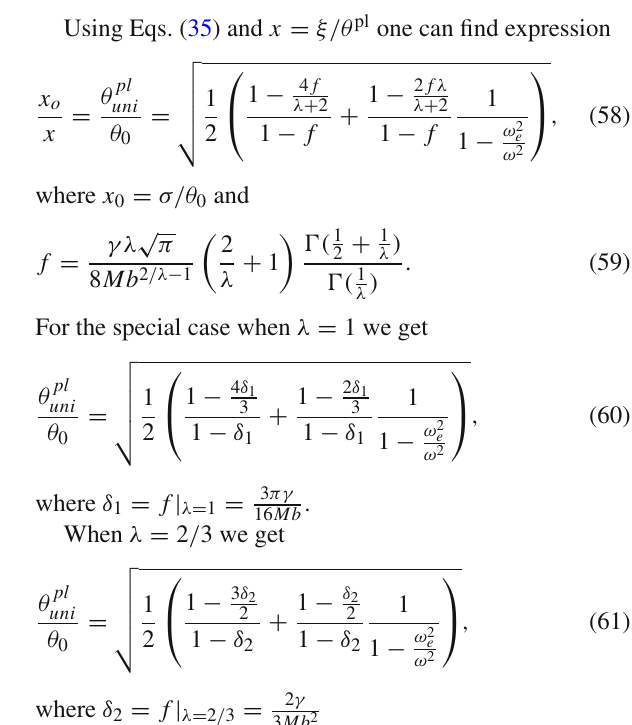
Fig. 18 α b for different value b , d and β in the non uniform plasma, λ = 1